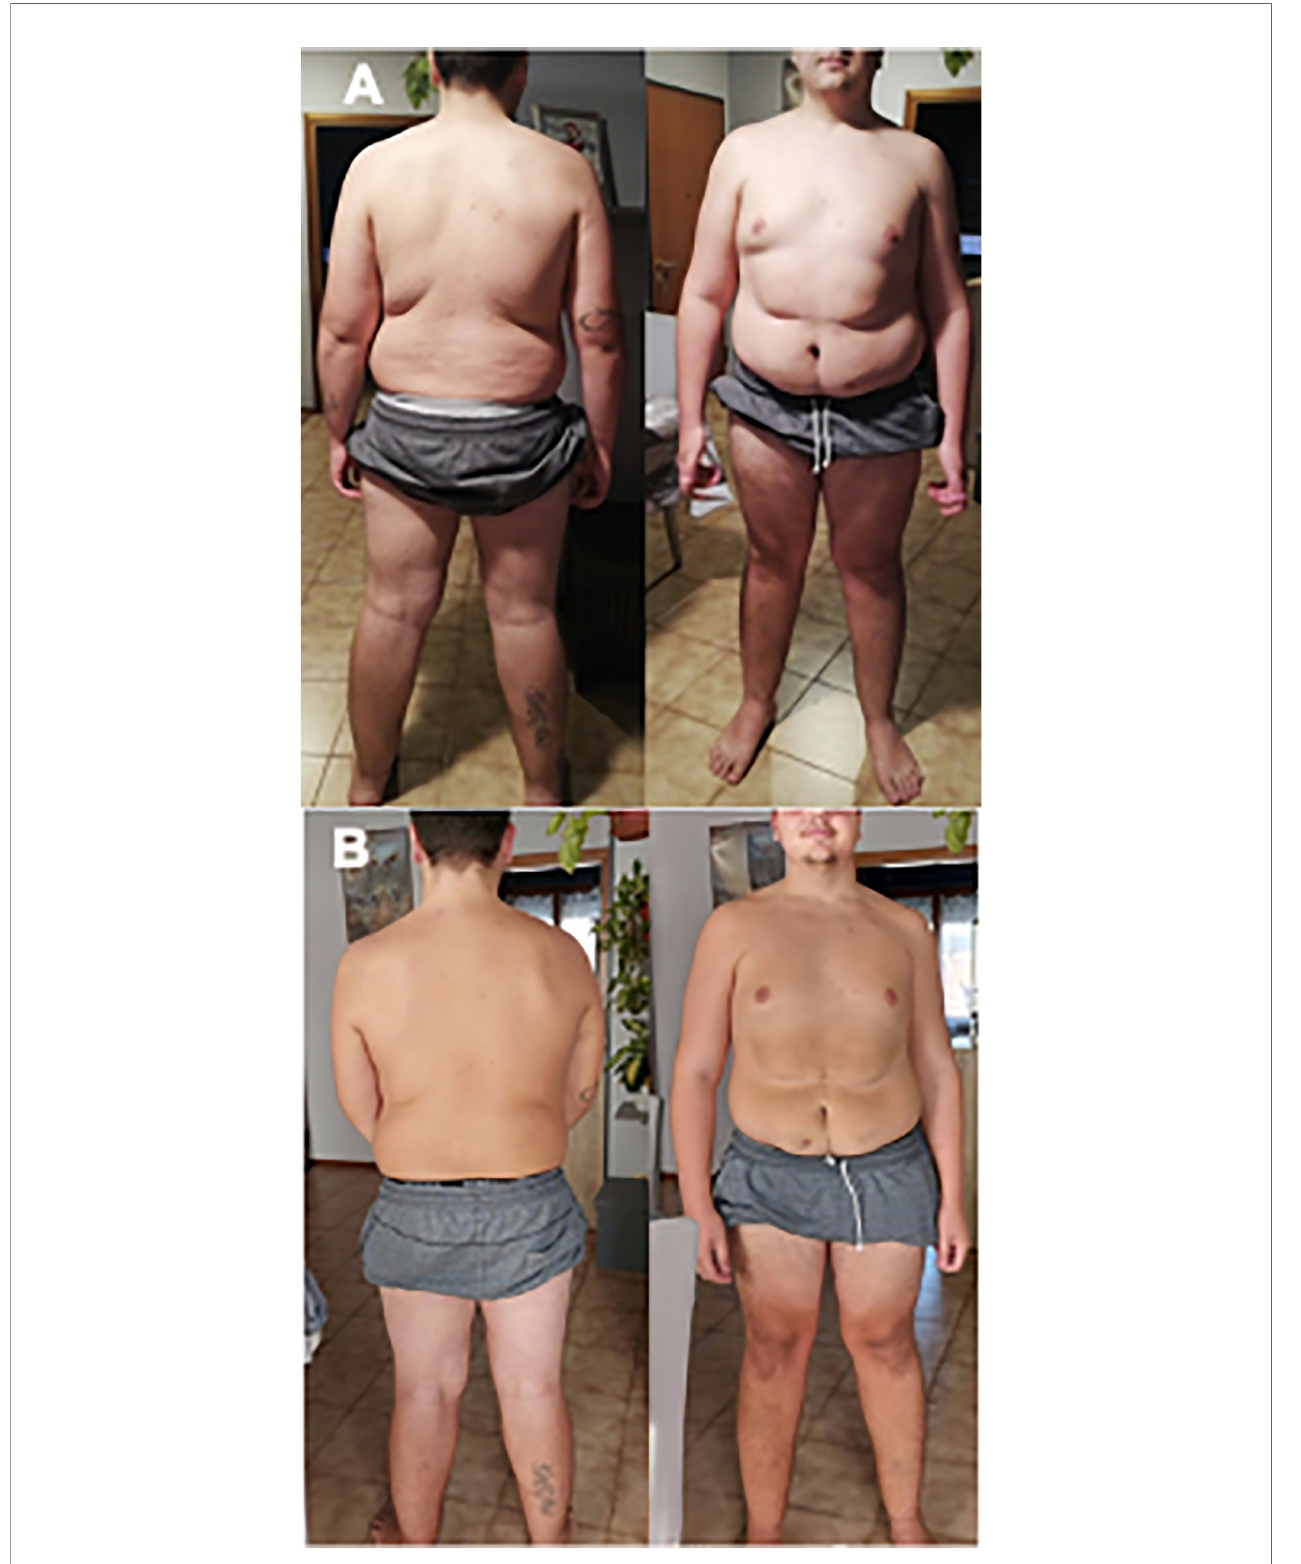
FIGURE 2 | Pictures of patient before (A) and after (B) liraglutide